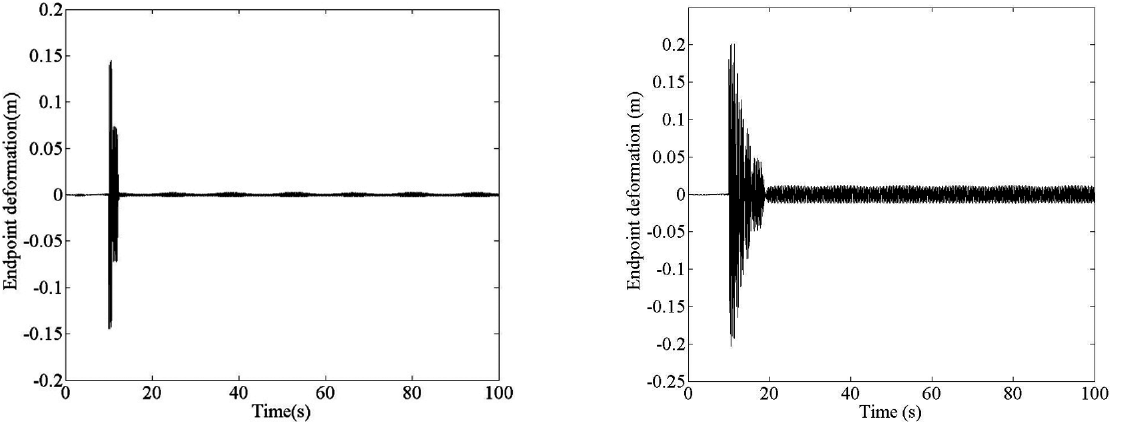
Fig. 10. Endpoint response of the controlled arm. Fig. 11. Endpoint response of the controlled